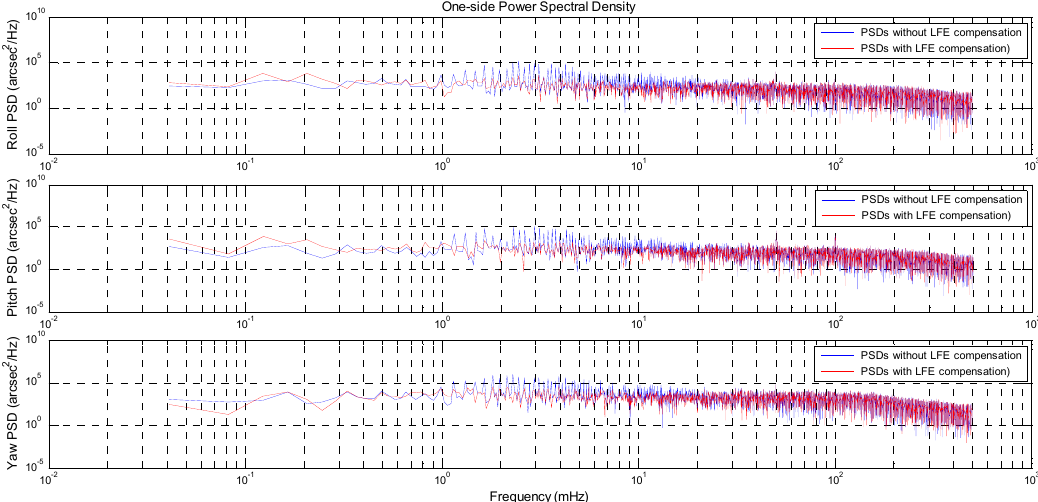
Figure 12. The power spectral densities of the REA residuals (with the x, y-axis in the logarithmic scale).